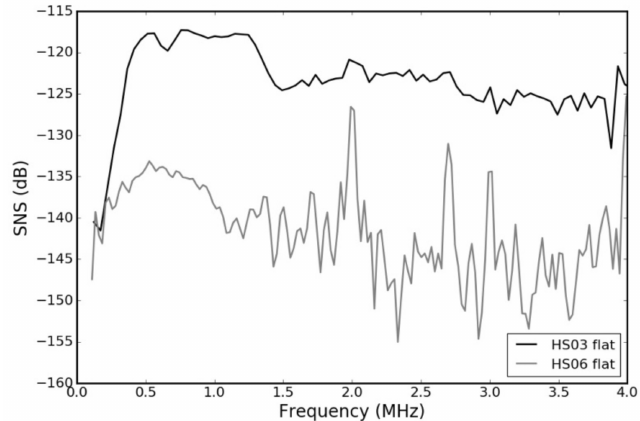
Figure 6. Pulse-echo sensitivity vs.